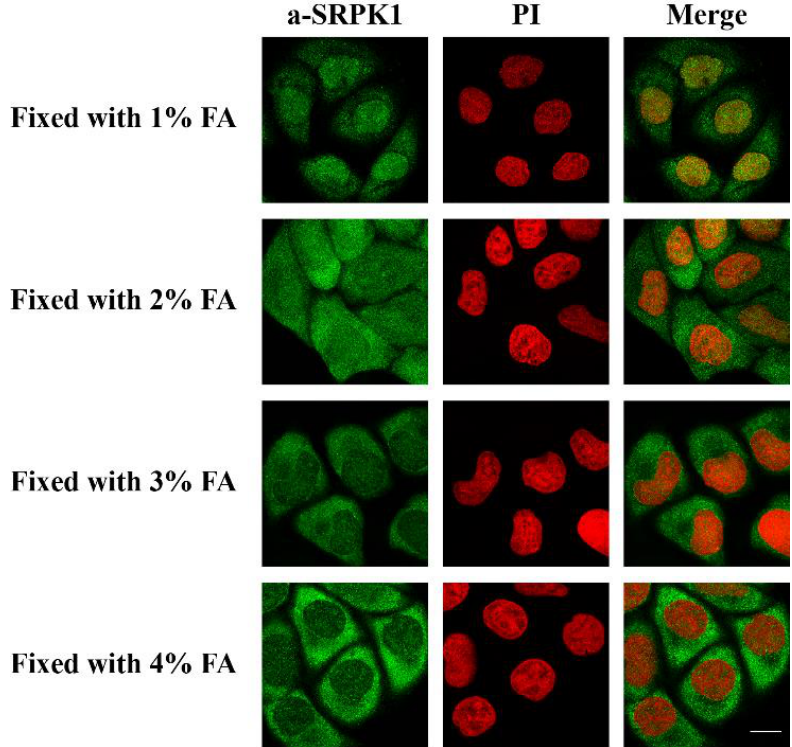
Figure 2. Fixation with various concentrations of formaldehyde (FA) affects the subcellular distribution of SRPK1. Fluorescent patterns of SRPK1 in HeLa cells fixed for 5 min with 1%, 2%, 3%, or 4% FA. SRPK1 was detected using the anti-SRPK1 monoclonal antibody, while nuclei were stained with PI. Scale bar: 10 µM.